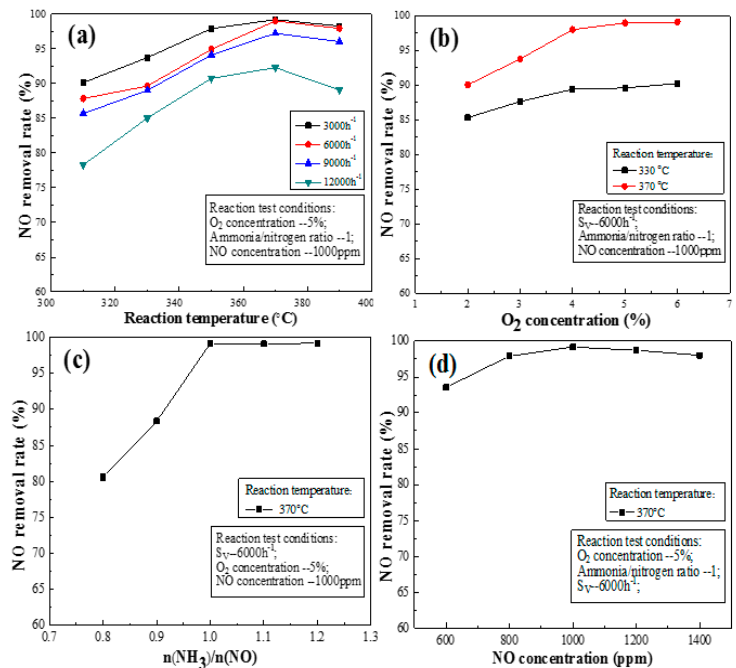
Figure 5. Effect of flue gas conditions on the NO removal rate of activated catalyst: ( a ) space velocity; ( b ) O 2 concentration; (c) ammonia/nitrogen ratio; and ( d ) NO concentration.